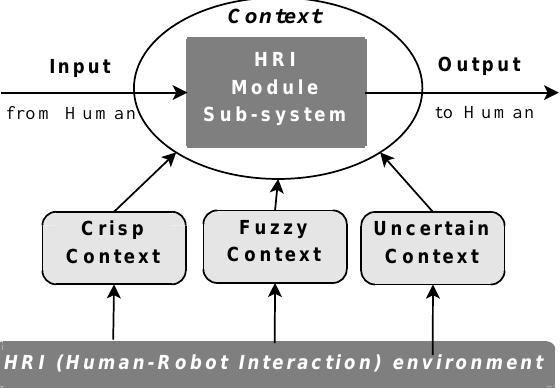
Fig. 3. HRI Module Subsystem in